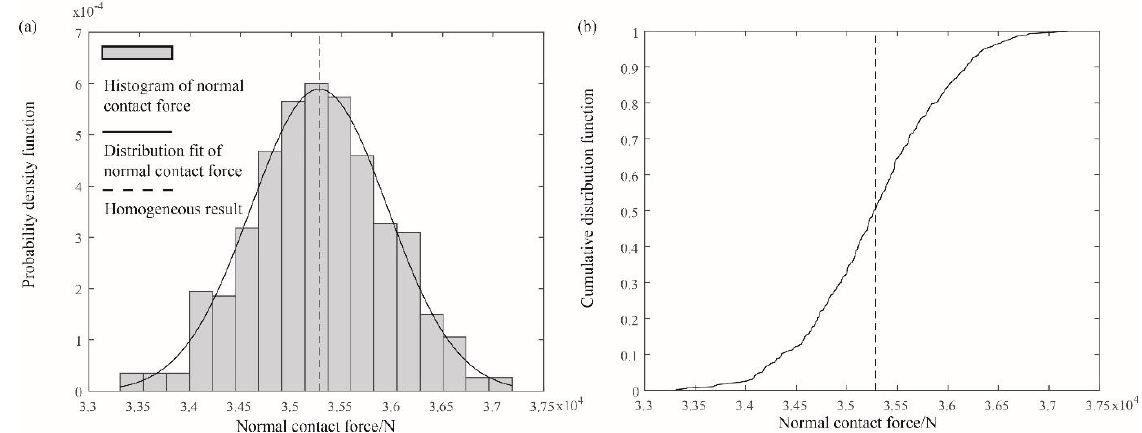
Figure 10. PDF ( a ) and CDF ( b ) of the normal contact force at the middle bottom point A of the elastic block from 500 realisations when the coefficient of friction is 0.3.